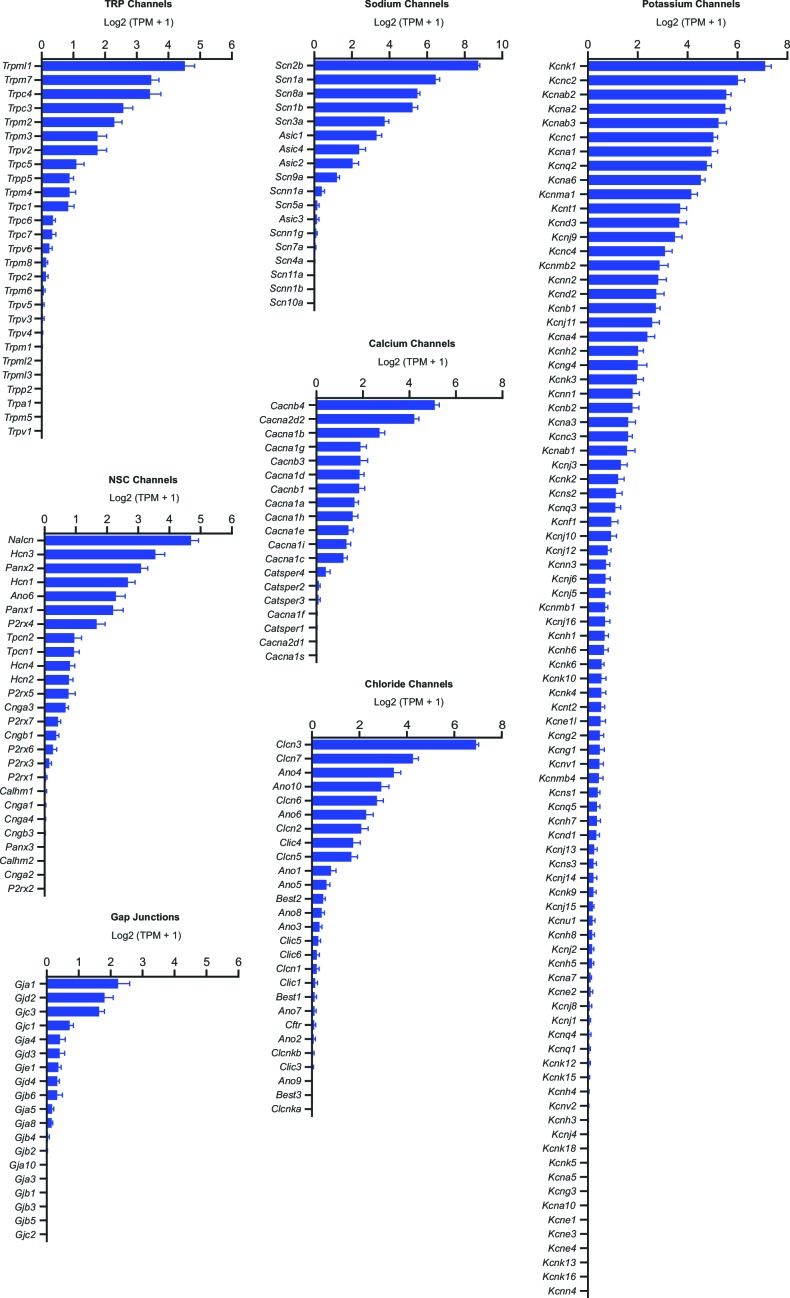
SNr neuron gene expression results for all ion channels.Average expression in log2(TPM + 1) of ion channel genes sorted (descending order) and grouped by type. Error bars indicate s.e.m.